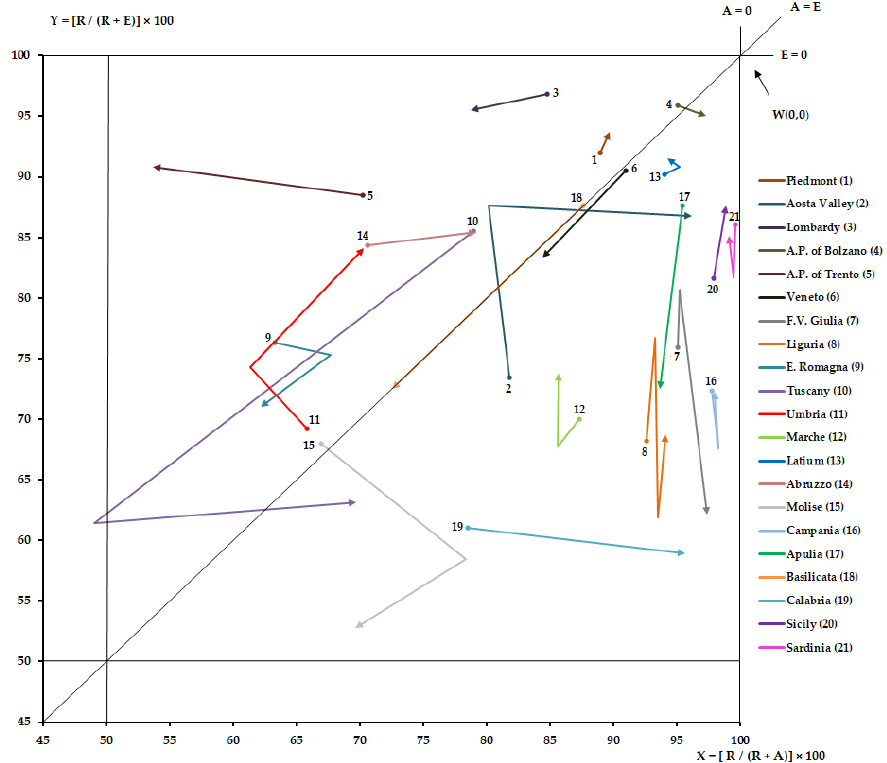
Figure 2. Zoom of NdG for hospital orthopedic intensive rehabilitation, from 2011 to 2019. Figure 3 shows financial mobility balance (A–F) of all Italian regions, for hospital intensive rehabilitation, from 2011 to 2019. On average, the financial flows of mobility were EUR 86.7 ± 3.0 million. Only Pied- mont, Lombardy, A.P. of Trento, E. Romagna, Umbria and Abruzzo had a positive balance for all studied periods. Aosta Valley, A.P. of Bolzano, Tuscany, Latium and Molise had positive balances for a few years. The other regions had constant negative balances. Only Lombardy (plus EUR 3.0 million) and A.P. of Trento (plus EUR 2.8 million) have increased their balance, and are already in surplus, significantly ( p < 0.05). Veneto (minus EUR 2 million), F.V. Giulia (minus EUR 0.5 million), Molise (minus EUR 0.9 million) and Apulia (minus EUR 1.0 million) have worsened their negative balance ( p < 0.05). E. Romagna (mi- nus EUR 2.8 million) has decreased its earnings ( p < 0.05). Calabria (plus EUR 0.8 million) and Sicily (plus EUR 1.6 million) tried to improve their negative balance ( p < 0.05).